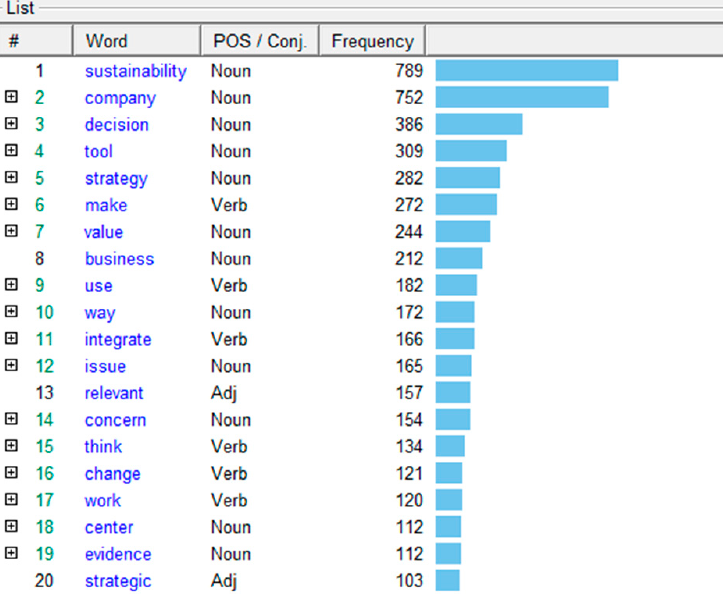
Figure 3. Word frequency list .